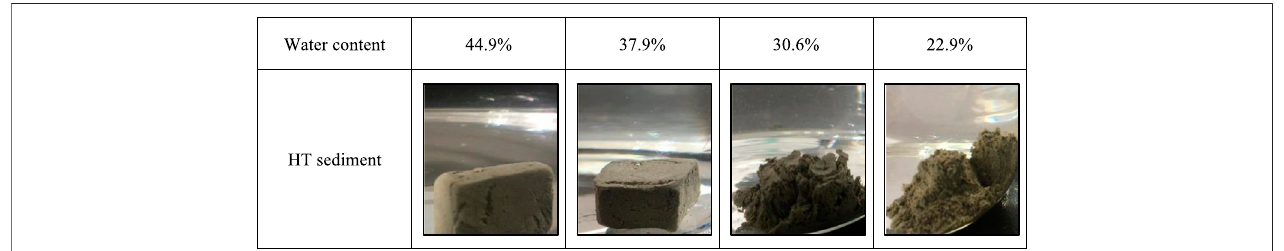
FIGURE 7 | Disintegration diagram of samples with different water content.